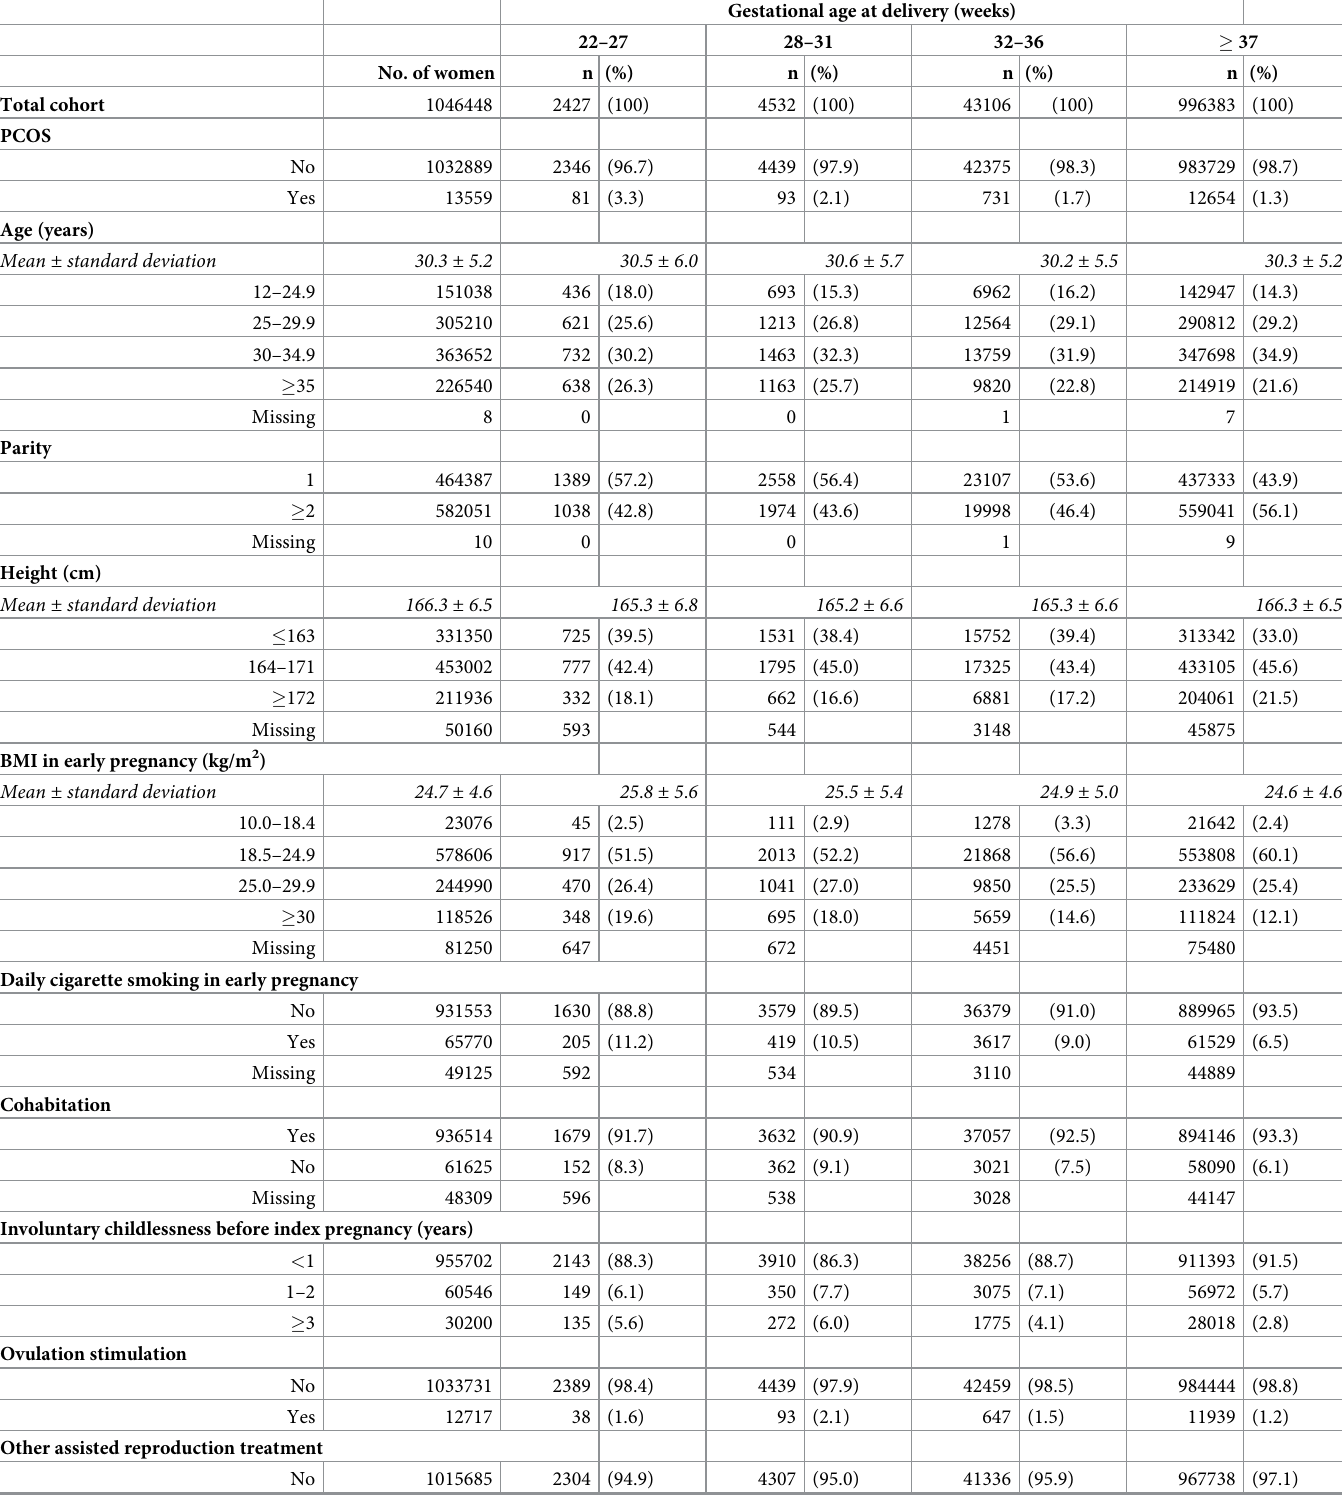
Table 2. Maternal characteristics and rates of preterm birth in women giving birth in Sweden